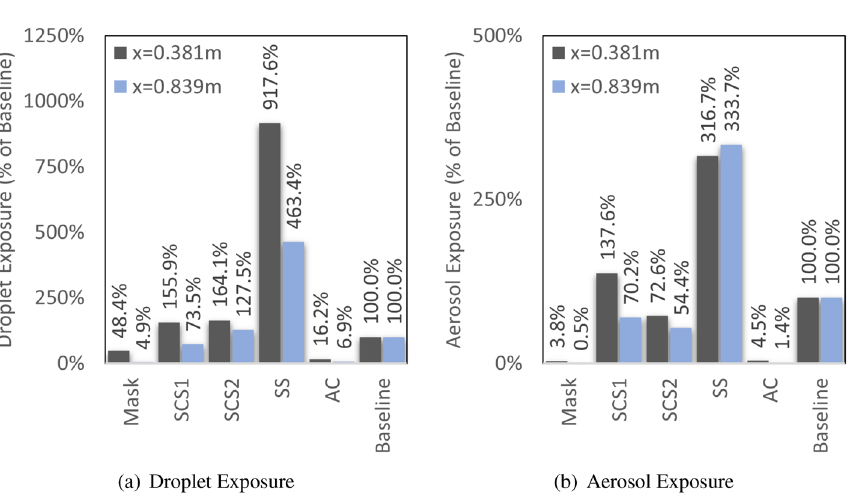
Figure 10. Overall potential of exposure to aerosols ( a ) and droplets ( b ) as a function of distance and normalized by a